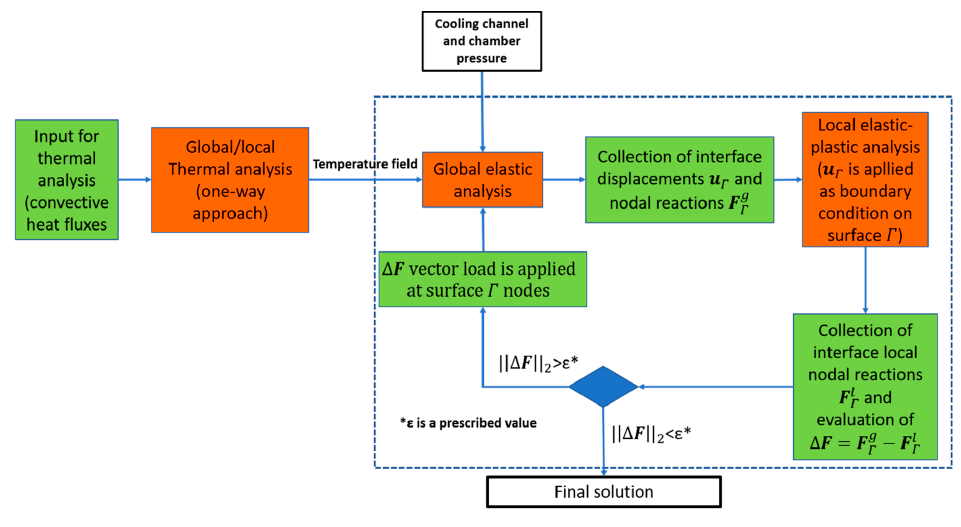
Figure 4. Scheme of the coupled solution loop.